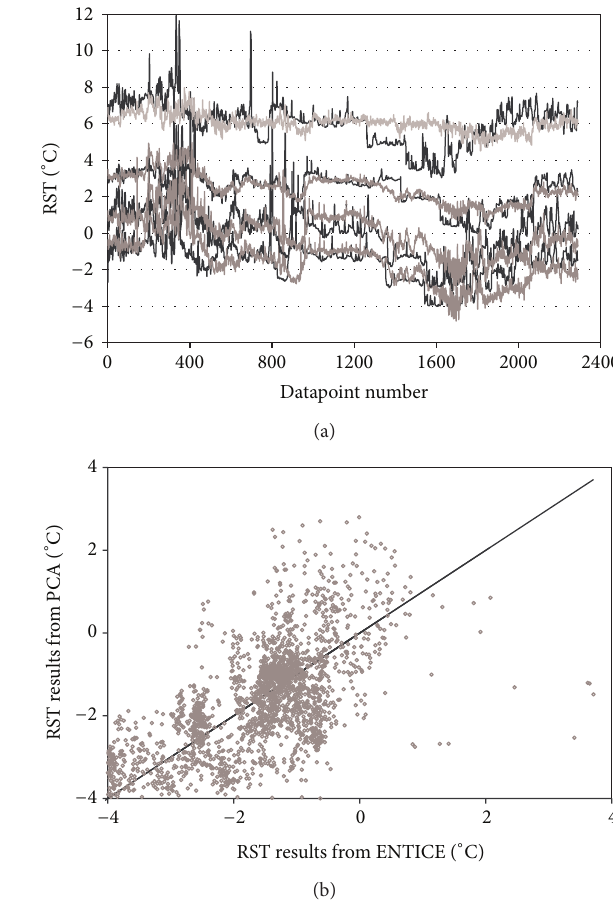
Figure 8: RST field measurements (solid black lines) and forecast (solid grey lines) based on interpolation of thermal fingerprints obtained from PCA on French (a) (January and February 2009 and October and December 2010) and UK (b) routes (two thermal fingerprints in December 1999, one in February 2000, and one in March 2000).